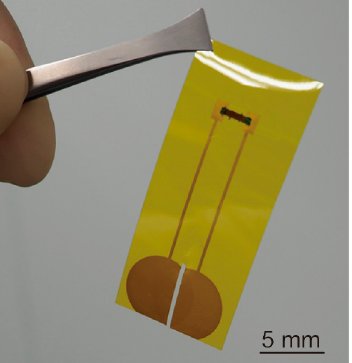
Figure 1. Photograph of the device that was fabricated by the proposed method. An ultrathin piezoresistive Si chip with a thickness of 5 µ m was mounted on the surface of the polyimide film tape together with the printed wirings.